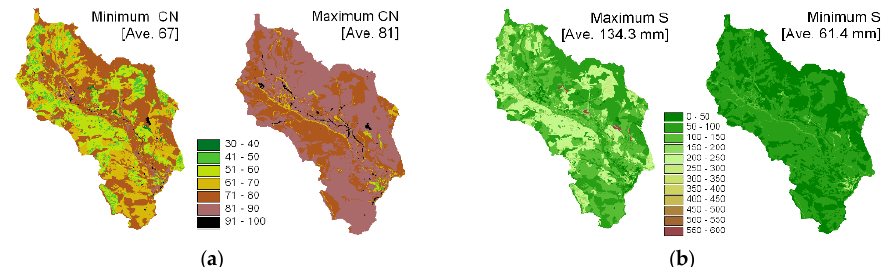
Figure 7. Maps of runoff curve number (CN) and potential maximum moisture retention (S) in Napa River basin: ( a ) The estimated runoff curve number; and, ( b ) The converted potential maximum retention from the runoff curve number.